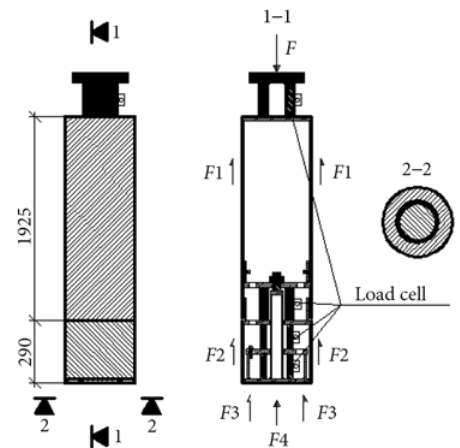
fig. 6. Principle scheme of the 1 st model pile